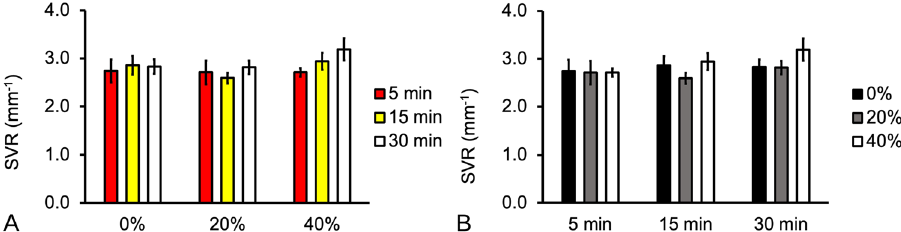
graph represented the average (plus – minus standard deviation of sample) of all the levels at each p W or at each t